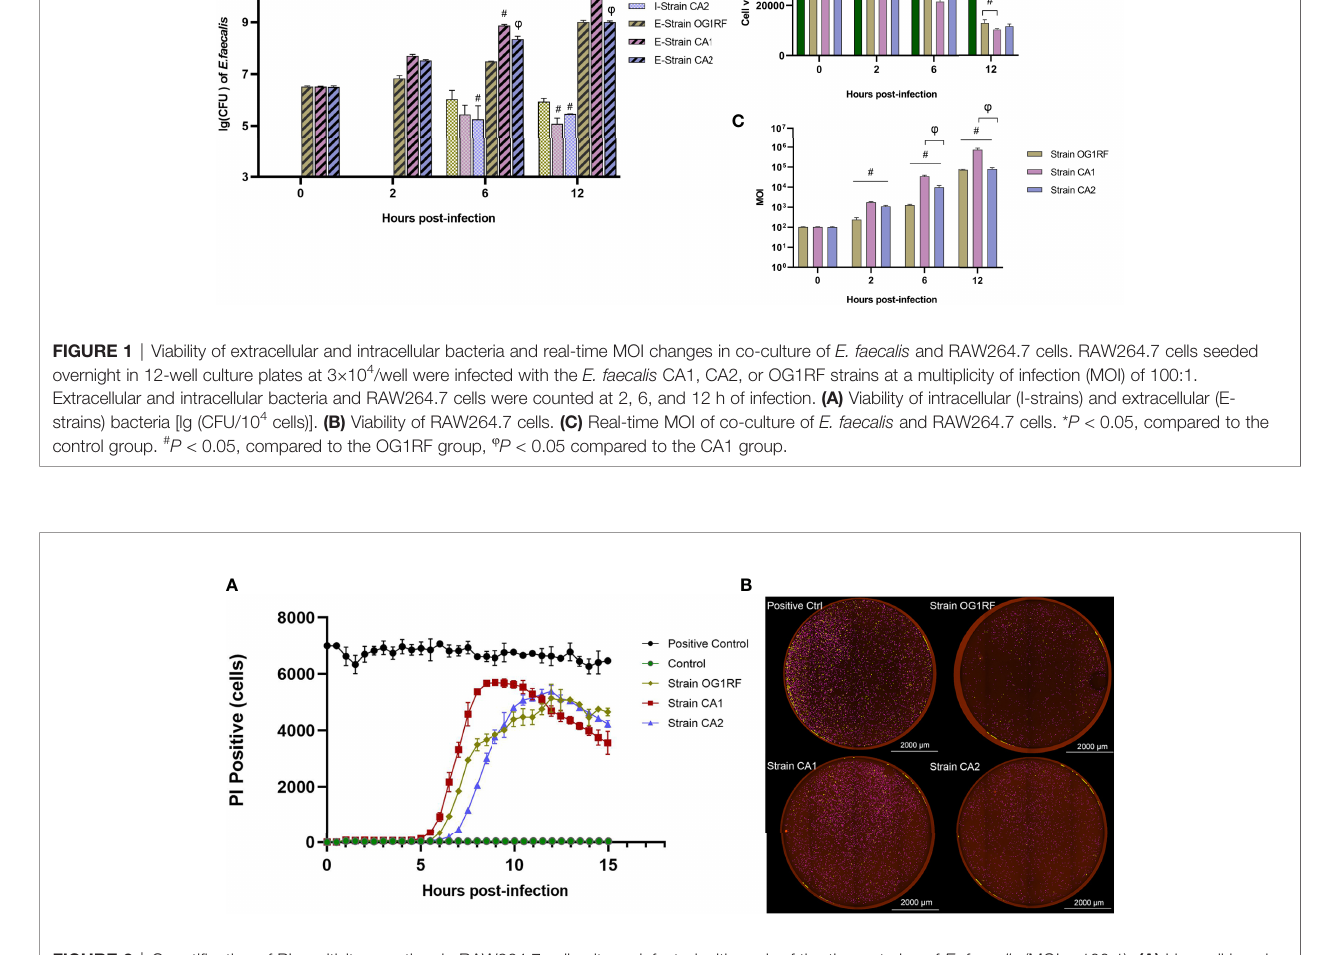
FIGURE 2 | Quanti fi cation of PI-positivity over time in RAW264.7 cell cultures infected with each of the three strains of E. faecalis (MOI = 100:1). (A) Live cell imaging (4×) quanti fi cation of PI-positivity in RAW264.7 cells infected with each of the three E. faecalis strains. (B) Representative cell death images with the red mask indicating dead cells at the maximum PI-positivity value. Scale bar: 2000 m